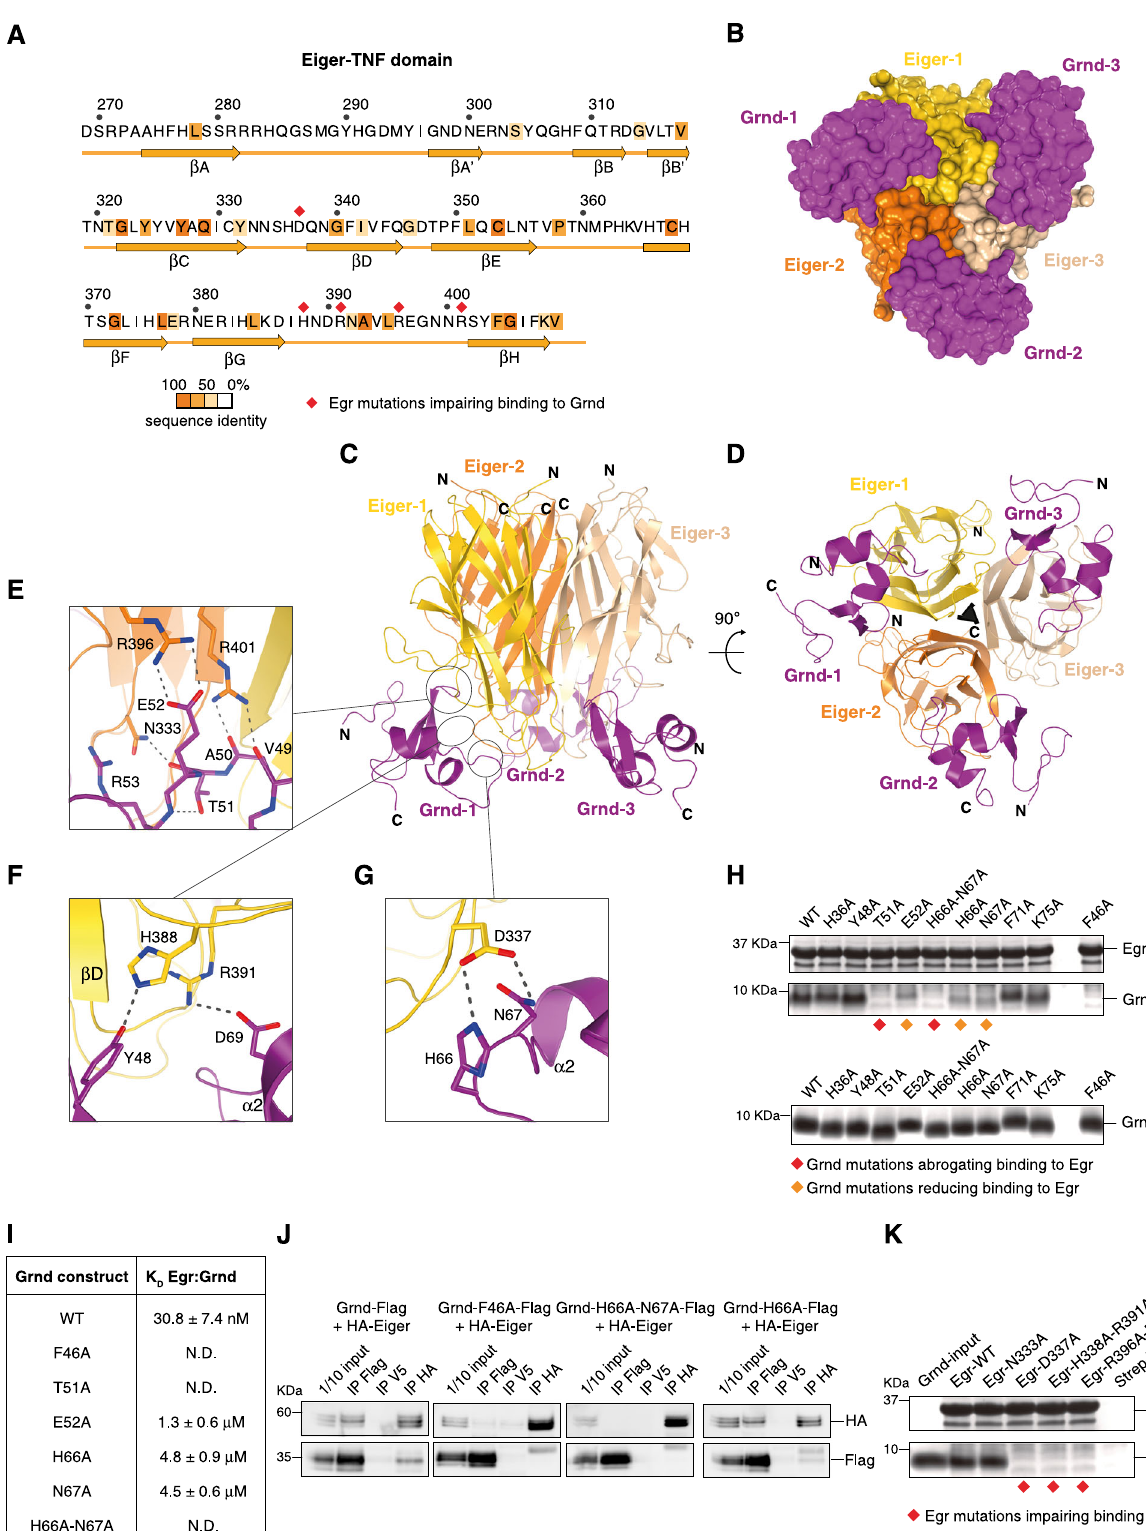
We then set out to address the relevance of the Grnd/Egr interaction in Egr-mediated signalling by introducing single or double mutations that impair binding to Egr in the endogenous grnd gene. We fi rst used a combination of CRISPR-induced double-strand breaks and ends-out homologous recombination to replace the fi rst coding exon of endogenous grnd with a